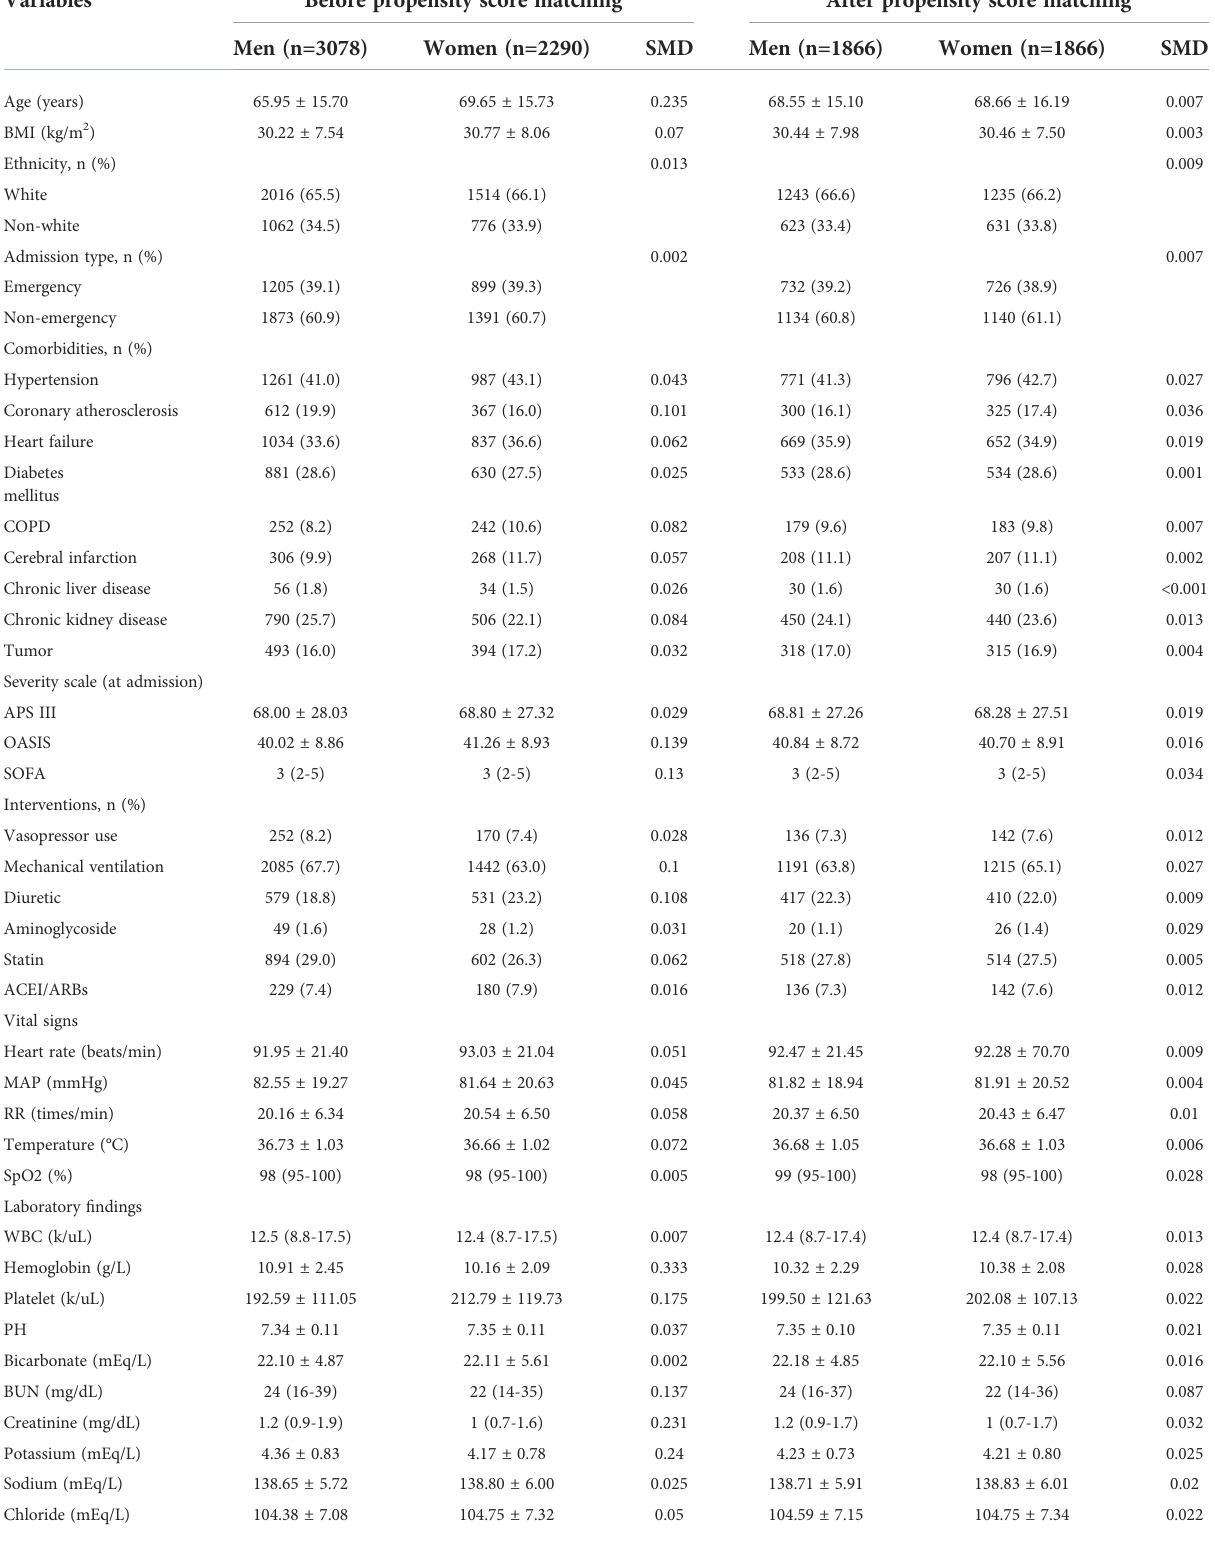
TABLE 4 Comparisons of baseline SA-AKI patient characteristics before and after propensity score matching.